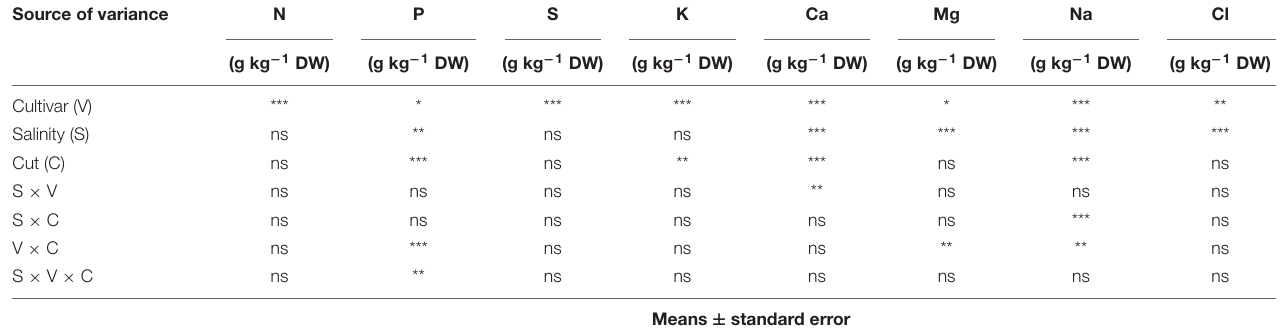
TABLE 4 | Analysis of variance (ANOVA) and mean comparisons for mineral [nitrogen (N), phosphorus (P), sulfur (S), potassium (K), calcium (Ca), magnesium (Mg), sodium (Na), and chlorine (Cl)] concentration of Green and Red cultivars cultivated under iso-osmotic salinity treatments and harvested in two sequential cuts. Source of variance